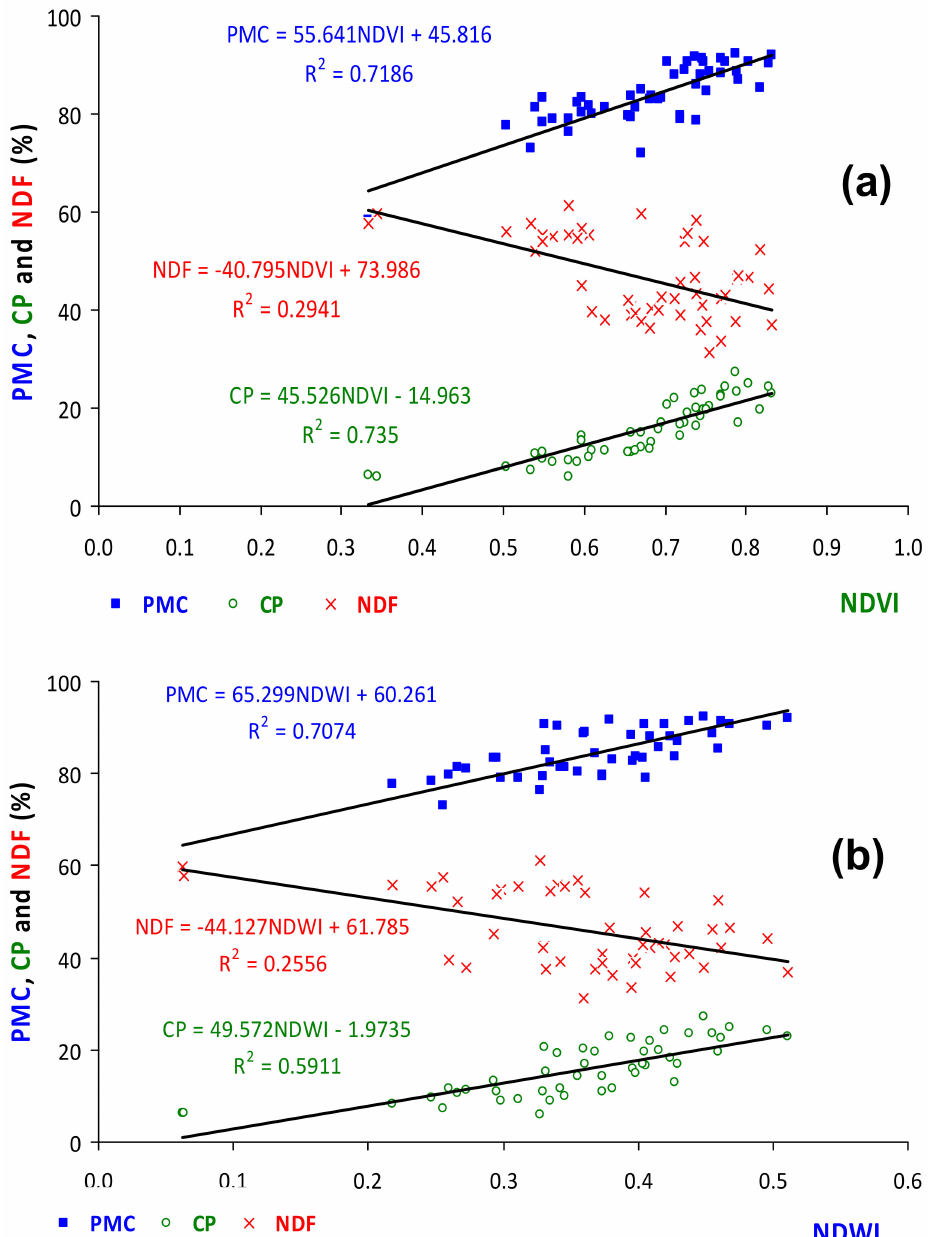
Figure 17. Relationships between mean pasture quality parameters (pasture moisture content, PMC; crude protein, CP; and neutral detergent fiber, NDF) and: ( a ) mean normalized difference vegetation index (NDVI); ( b ) mean normalized difference water index